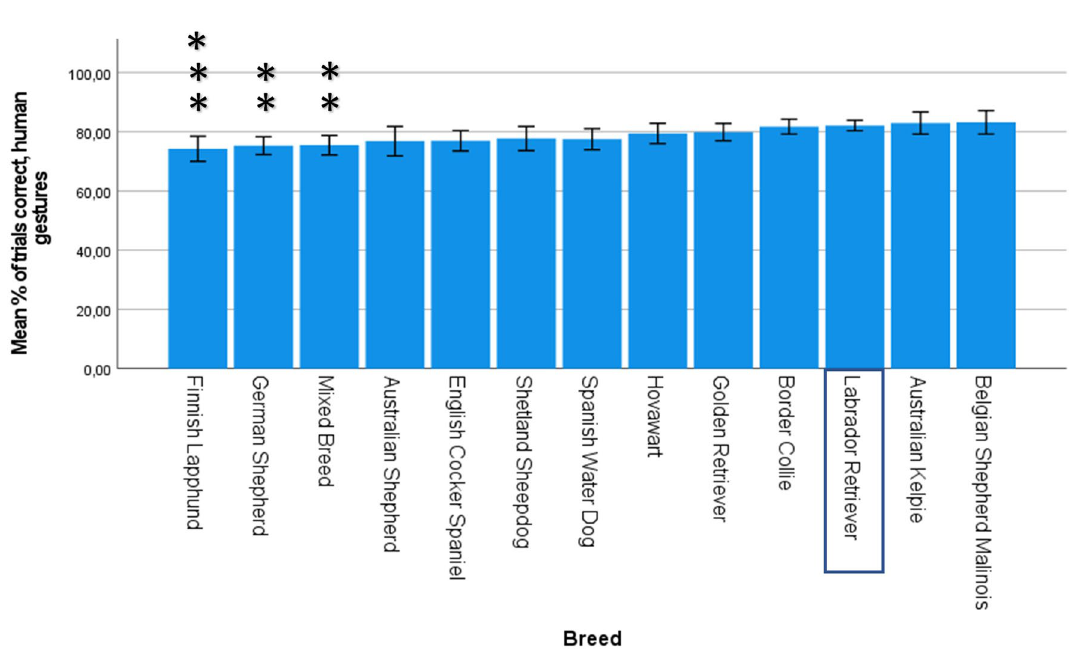
Figure 3. Mean percentage of correct trials in the gesture tests within each breed (n = 831). Error bars represent 95% confidence intervals. Breeds have been ordered based on B-values, with lowest success on the left and highest success on the right. The Labrador Retriever was used as the reference breed. Significant P-values (Bonferroni-corrected) are indicated with asterisks: ***p ≤ 0.001, **p ≤ 0.01, *p ≤